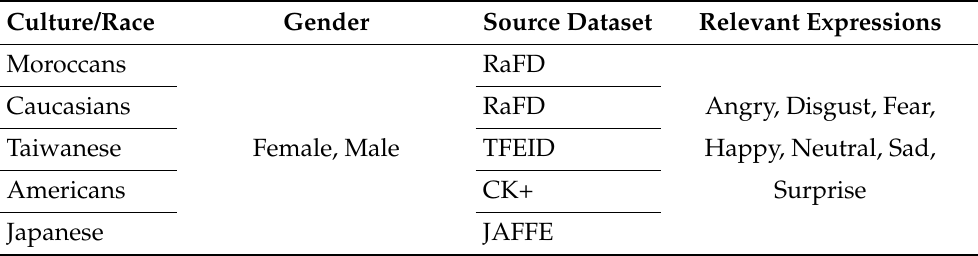
Table 1. Description of multi-culture facial expression database.